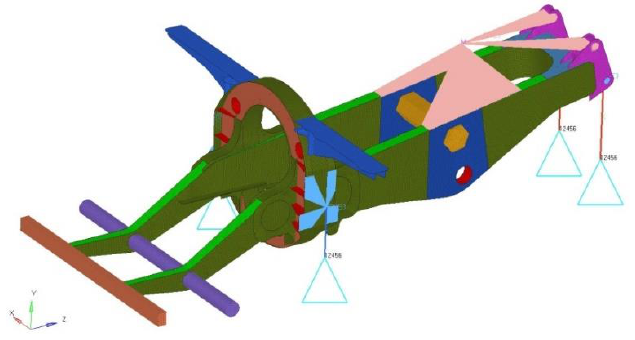
Figure 1. Finite element model of frame.